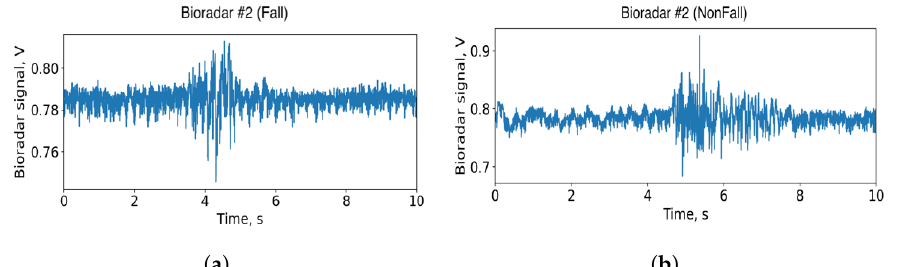
Figure 5. Examples of the preprocessed signal of similar patterns. ( a ) The fall event. ( b ) The squatting